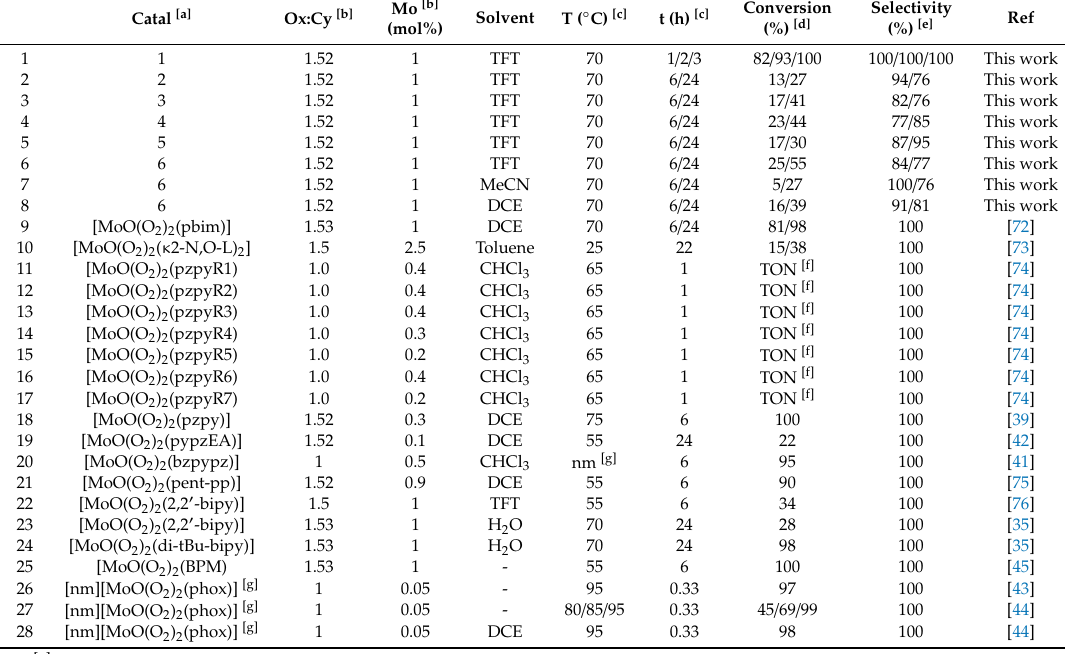
Table 2. Comparison of the catalytic results of the compounds prepared to literature data for complexes consisting of neutral or ionic [MoO(O 2 ) 2 (L) n ] tested for the model reaction of Cy /